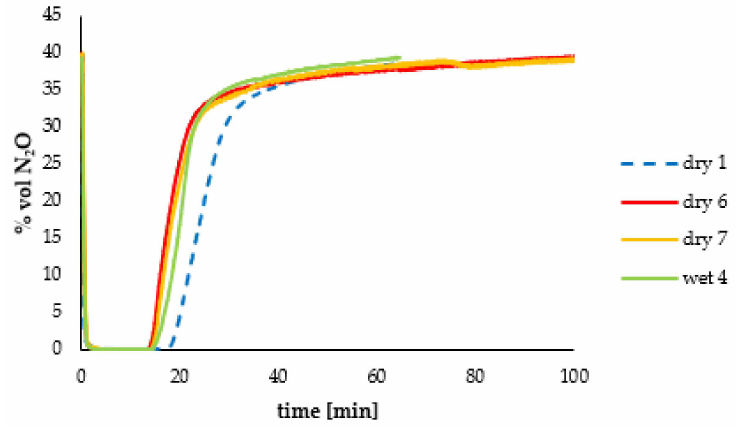
Figure 12. Wet and dry tests on the third zeolites batch (without Fe) compared to the first dry test (dry 1).